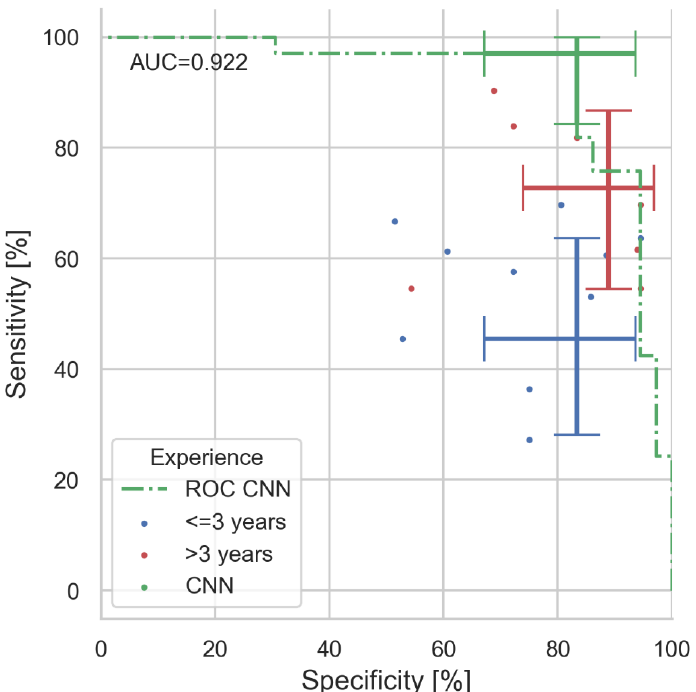
Figure 2. Results of man vs. machine validation. In total, 69 images (33 PG, 36 UC) were diagnosed by 18 dermatologists and our CNN algorithm. Coloured dots indicate the individuals’ performance (colour coded for professional experience). Error bars indicate the value and the 95% confidence intervals for sensitivity and specificity for CNN, expert, and juniors (majority decisions within experience group). With 97%, the CNN clearly outperforms even experienced physicians in sensitivity (correct PG diagnosis rate), whereas specificity is similar. The area under curve (AUC) of the presented CNN ROC is